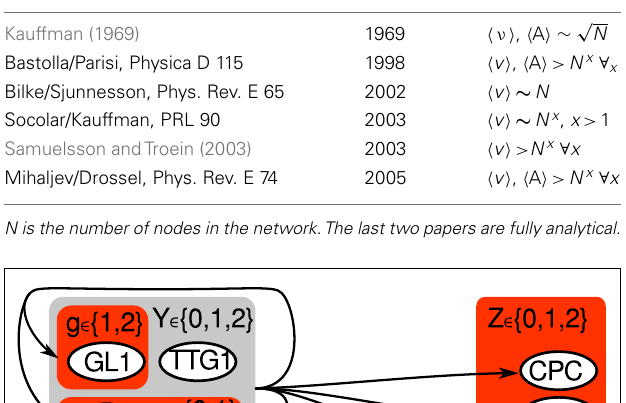
TableA1 | Different results for the mean number (cid:104) v (cid:105) and the mean length (cid:104) A (cid:105) of attractors in the course of time.